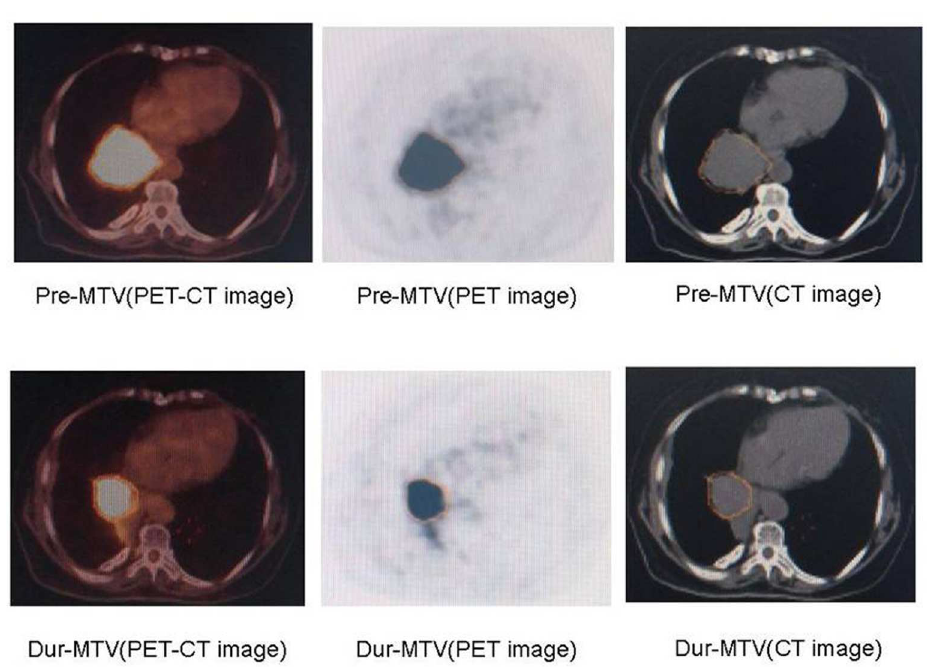
Fig 2. Comparison of MTVs pre-RT and dur-RT. MTVs, metabolictumor volumes; RT, radiotherapy.